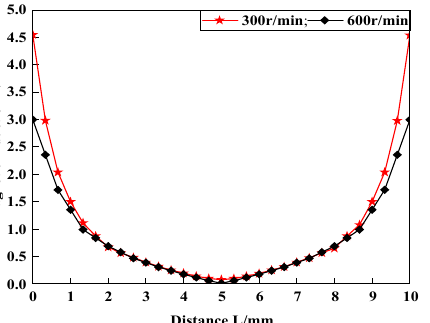
Figure 11. Magnetic field of the sealing gap under 300 and 600 rpm speed conditions.